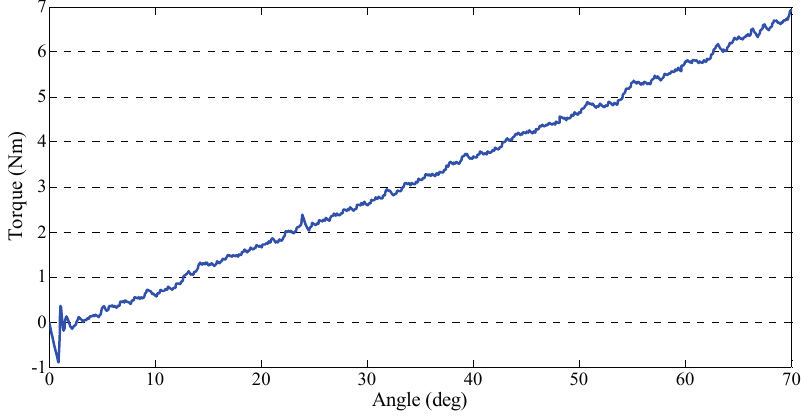
Figure 10. Gradually increased torque from the master